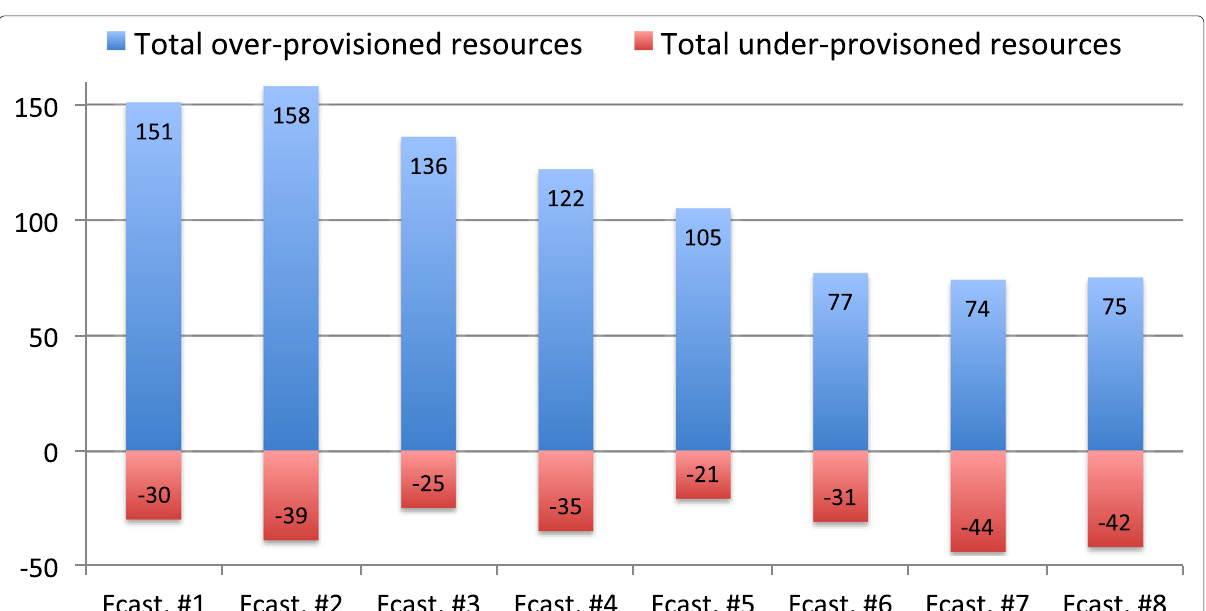
Fig. 10 Over- and under-provisioning of resources using different forecasting models, based on the resource allocation of Table 6 This figure shows the total number of over-provisioned and under-provisioned resources over the 24 h test interval for the different forecasting models (#1 to #8), based on the resource allocation of Table 6. This is computed as the difference between the number of resources that should be provisioned according to the predicted load of the different forecasting models, and the optimal number of resources that should be provisioned according to the real load of the server for the 24 h test